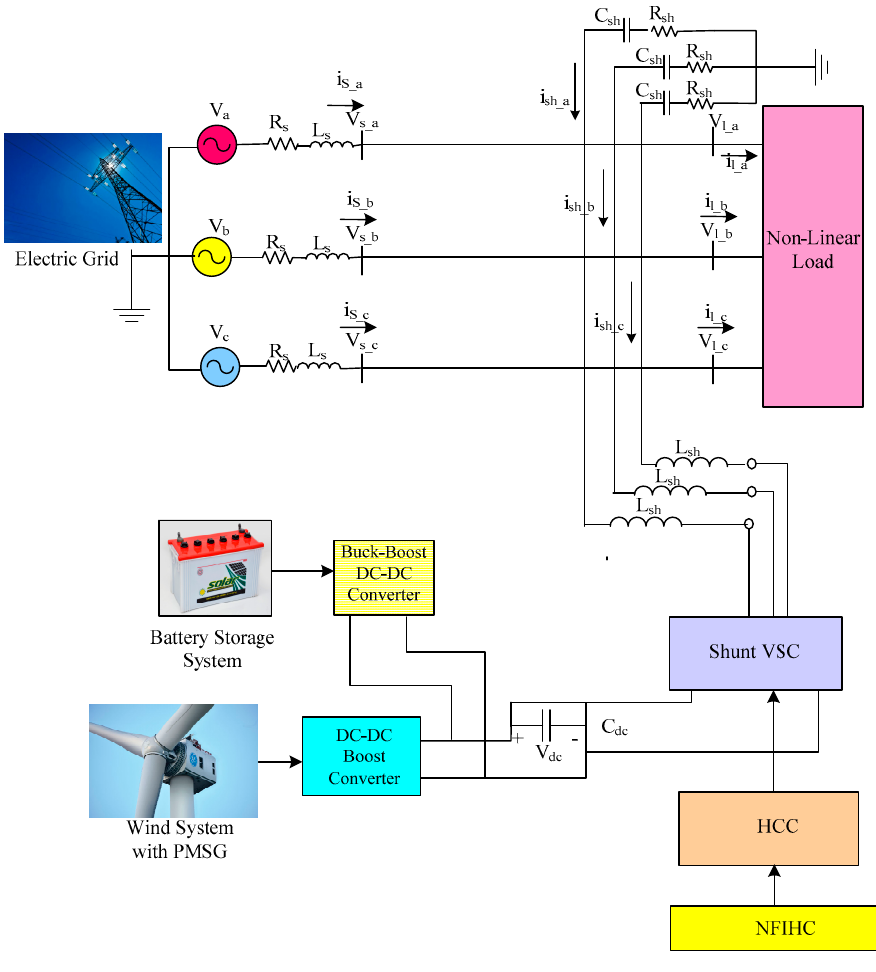
Figure 1. Construction of SH-WPBS.